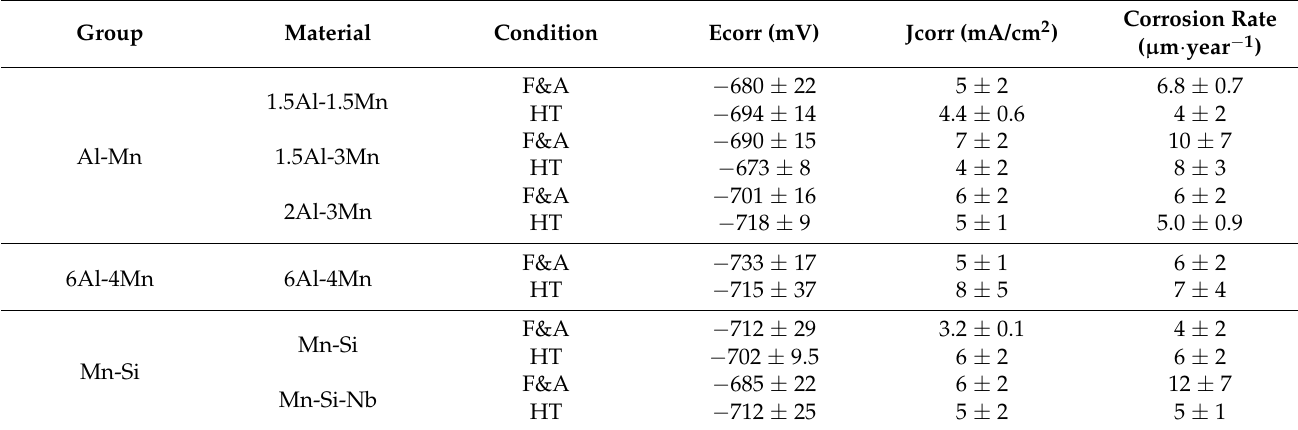
Table 3. Potentiodynamic test—average results of three repeats with standard deviation, F&A—forged and annealed, HT—heat treated.